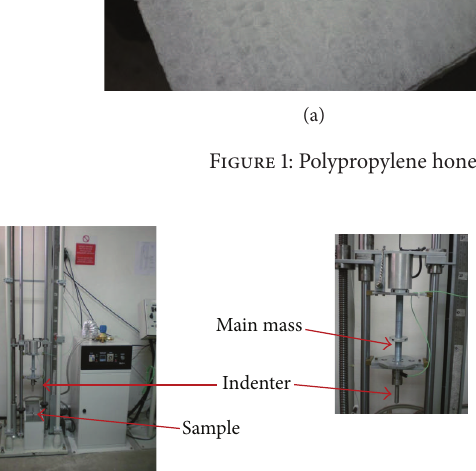
Figure 2: Drop weight impact testing machine.